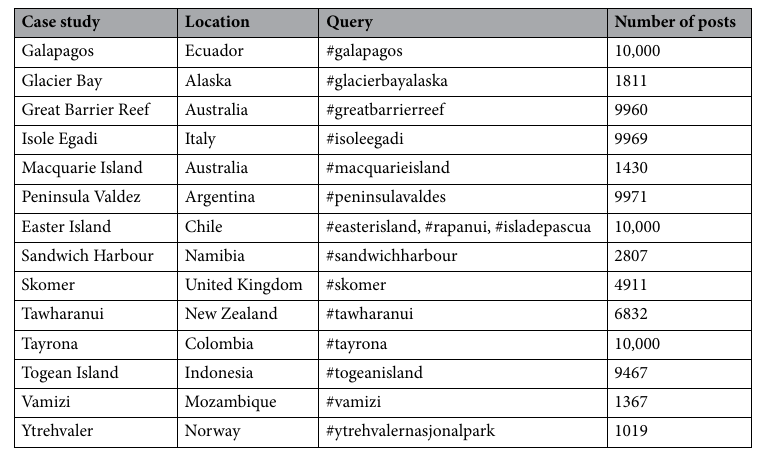
Table 1. Case study name, location, query and number of posts downloaded for the